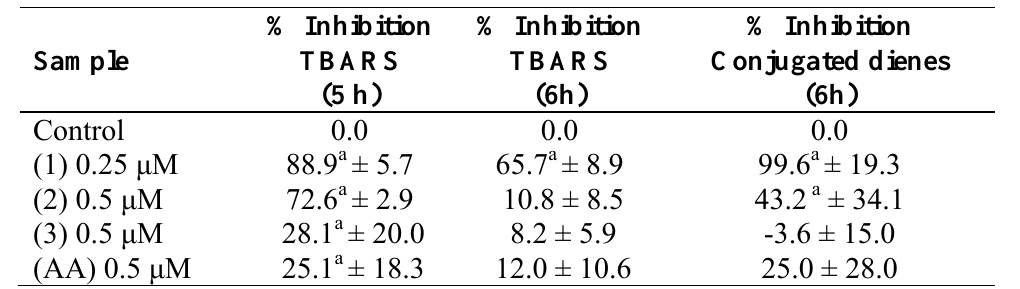
Table 1. Inhibitory effect (%) of isoorientin ( 1 ), swertiajaponin ( 2 ) and isoorientin 2"- O - rhamnoside ( 3 ) on TBARS and conjugated diene formation during copper-mediated LDL